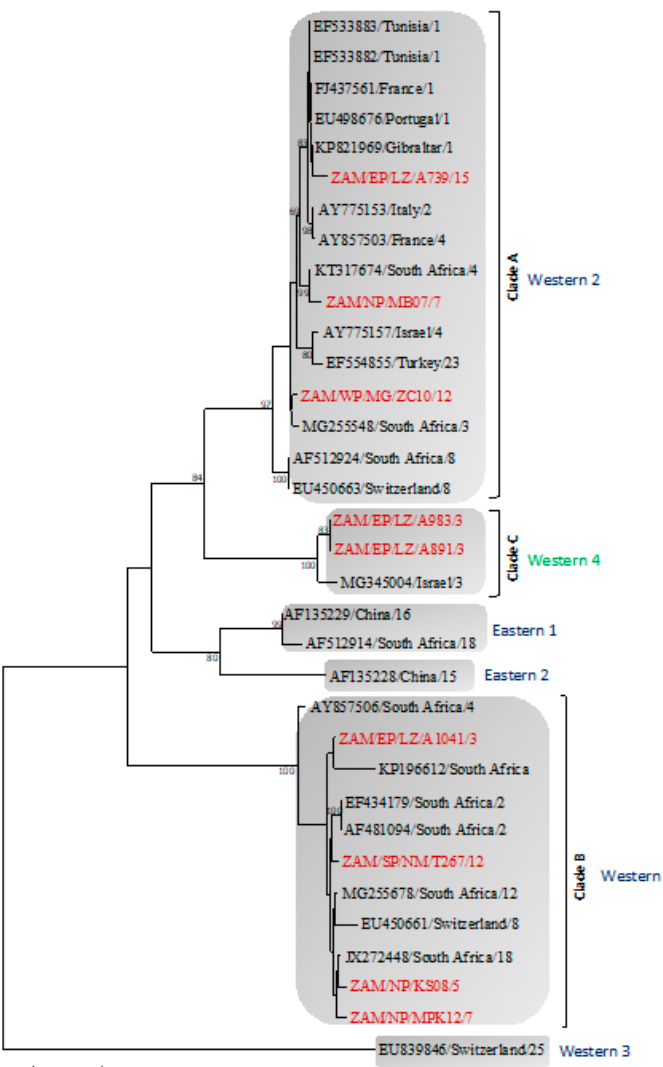
Figure 3. Phylogenetic tree of segment 10 gene of viruses detected in this study. The tree was generated using the Maximum Likelihood method based on the Tamura 3-parameter (T92) model with 1000 bootstrap replicates. Numbers at branch nodes indicate bootstrap values ( > 60%). Viruses characterized in the present study are in red text. Novel topotype is in green text. Right brackets—clade. Shaded area—topotype. Reference sequences for Western and Eastern topotypes are in black text. Bar—number of nucleotide substitutions per site. Abbreviations: EP, Eastern Province; SP, Southern Province; WP, Western Province; NP, Northern Province; LZ, Lundazi; MG, Mongu; NM, Namwala; MB,